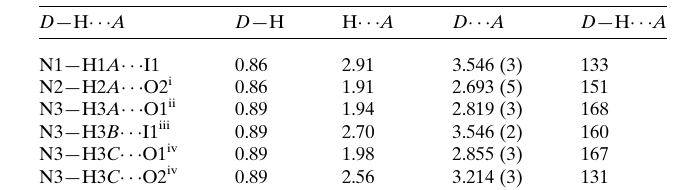
Table 1 Hydrogen-bond geometry (A˚ , (cid:5)